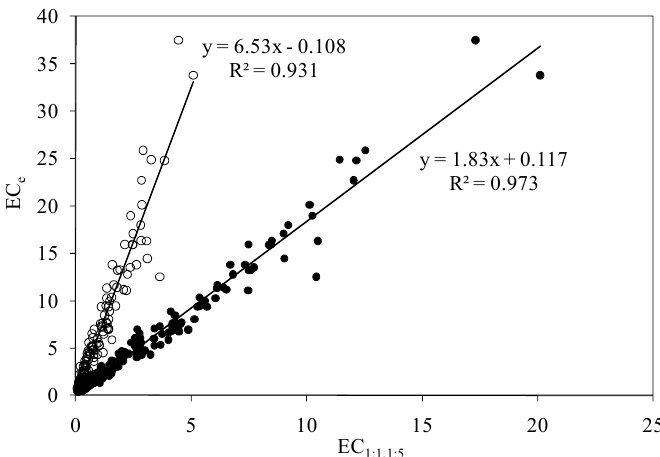
Figure 2. The EC e = f (EC 1:1 ) and EC e = f (EC 1:5 ) relationships for combined soil texture data (N = 198). Dark circles for EC e = f (EC 1:1 ) and open circles for EC e = f (EC 1:5 ) relationships. The values of EC in dS m − 1 ). The studied soil samples were grouped according to their Saturation Percentage (SP%) values, and two EC e = f (EC 1:1 ) linear curve fitting prediction equations were produced (Figure 3).